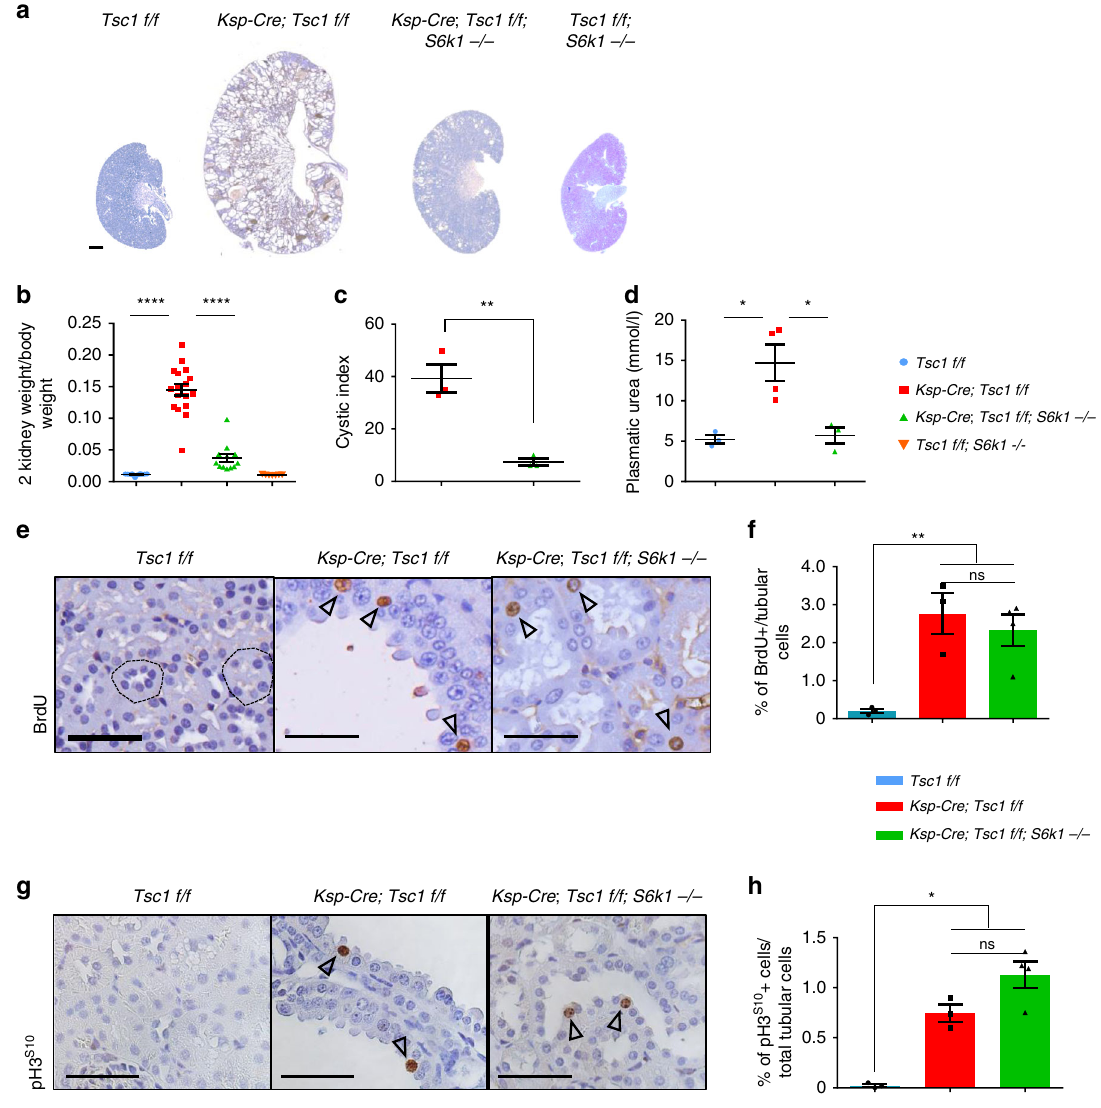
Fig. 1 S6K1 deletion protects from cyst formation in a mouse model of renal TSC without affecting proliferation. a Macroscopic photos of BrdU staining at post-natal day 90 of the different genotypes indicated. Scale bar, 1 mm. b Kidney/body weight ratio of the indicated phenotypes at post-natal day 90. Mean ± SEM. n = 12 Tsc1 f/f, n = 17 Ksp-Cre; Tsc1 f/f and n = 12 Ksp-Cre; Tsc1 f/f; S6k1 − / − mice were quanti fi ed. c Cystic index – (total cystic area/total kidney area) × 100 – of mice of indicated genotypes. Mean ± SEM. n = 3 mice/group. d Plasmatic urea concentrations (mmol/l) were determined in the indicated genotypes at post-natal day 20. Mean± SEM. n = 3 Tsc1 f/f, n = 4 Ksp-Cre; Tsc1 f/f and n = 3 Ksp-Cre; Tsc1 f/f; S6k1 − / − mice were quanti fi ed. e Representative pictures and f relative quanti fi cations of BrdU staining at post-natal day 90 of the indicated genotypes. The percentage of BrdU-positive cells on the total number of tubular cells was counted in 10 different fi elds of each section. Dotted circles show transversal cuts of normal tubules. Empty arrows point at positive cells. Mean ± SEM. n = 3 Tsc1 f/f, n = 3 Ksp-Cre; Tsc1 f/f and n = 4 Ksp-Cre; Tsc1 f/f; S6k1 − / − mice were quanti fi ed n = 3 mice/ group. Scale bar, 20 µ m. g Representative pictures and h relative quanti fi cations of pH3 S10 staining at post-natal day 90 of the different genotypes indicated. The percentage of pH3 S10 -positive cells on the total number of tubular cells was counted in 10 different fi elds of each section. Empty arrows point at positive cells. Mean ± SEM. n = 3 Tsc1 f/f, n = 3 Ksp-Cre; Tsc1 f/f and n = 4 Ksp-Cre; Tsc1 f/f; S6k1 − / − mice were quanti fi ed. Scale bar, 20 µ m. Source data are provided as a Source Data fi